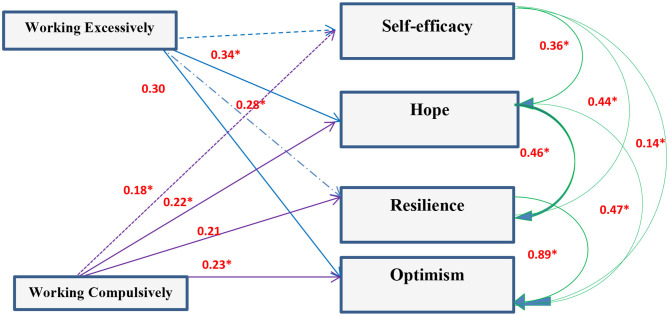
Path diagram of the model used for the whole group of subjects for work addiction scores and Psychological capital components (n = 1,080) (Multiple regression analysis using pathway analysis was applied). *significant.